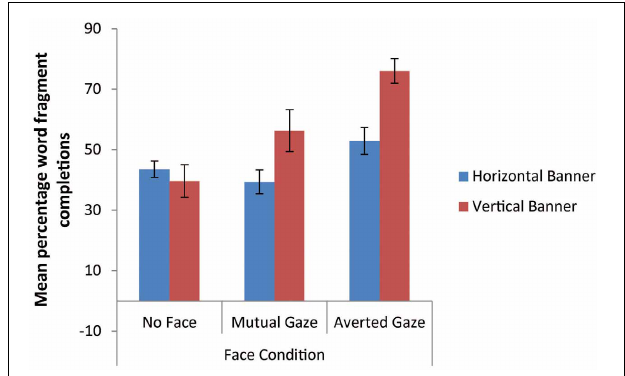
FIGURE 13 | Mean percentage correct word fragment completions for items as a function of banner type (vertical vs. horizontal) and face condition (error bars depict the standard error of the